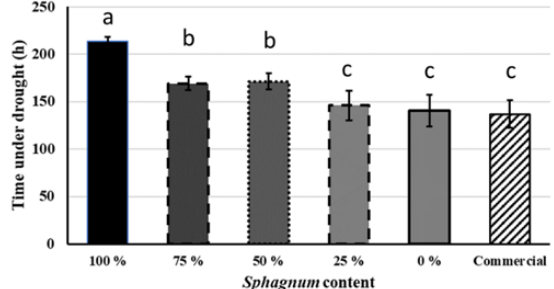
Figure 5. The average time elapsed between the beginning of the drought experiment and the wilting of sweet basil plants. Y-axis denotes elapsed time from the beginning of the drought period. Letters indicate significant differences between groups (p < 0.05). Bars denote ± SD. n =